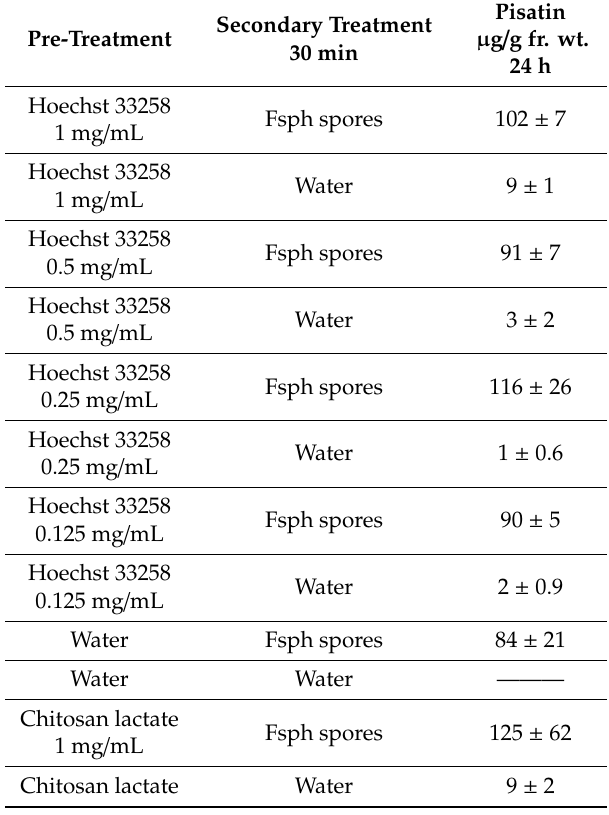
Table 7. The e ff ect of Hoescht 33258 and / or Fsph spores (3 × 10 6 ) on the production of pisatin in pea tissue after 24